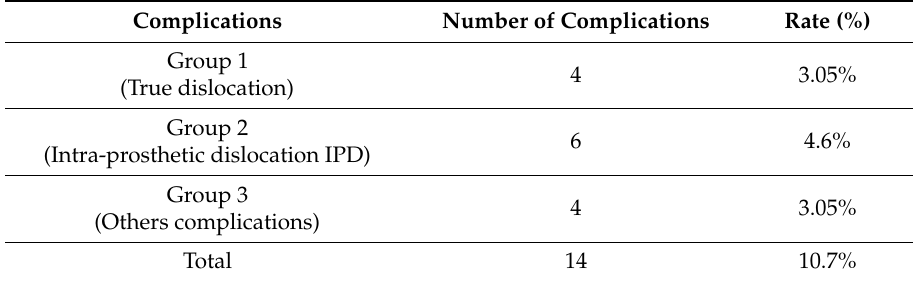
Table 2. Group 1: True dislocation; Group 2: IPD (Intra-prosthetic dislocation); Group 3: other